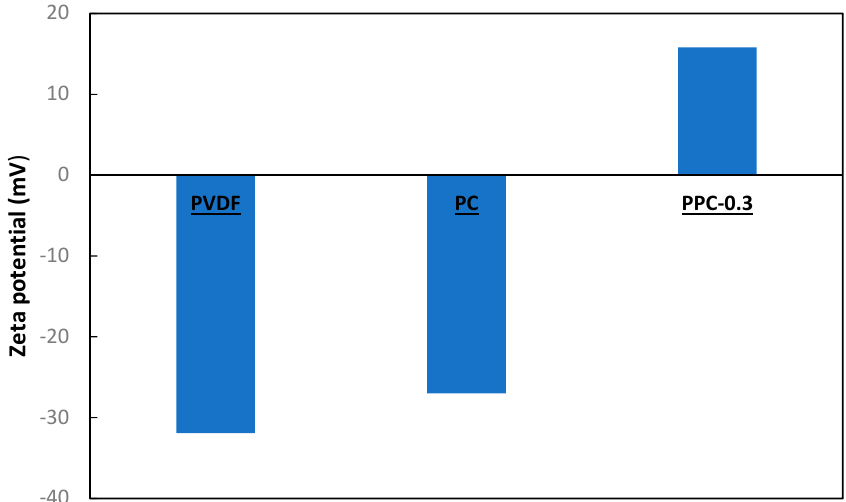
Figure 5. Zeta potential for modified membranes.